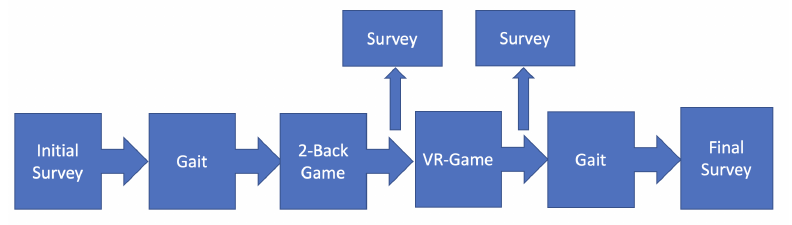
Figure 2. Flow of the data collection steps.